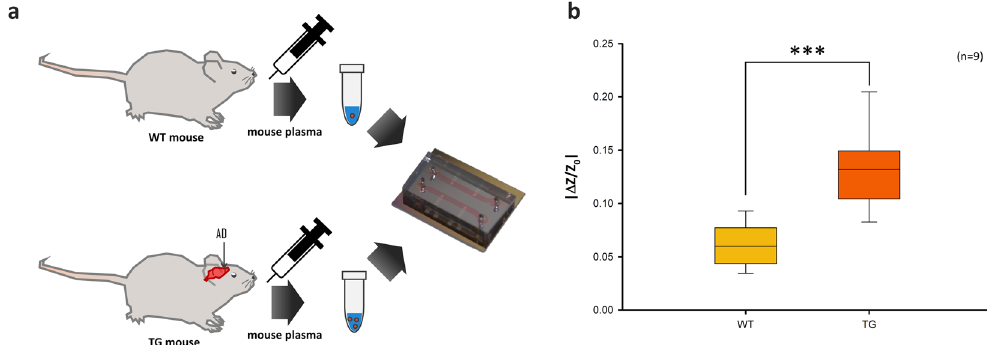
Figure 5. Mouse model test. ( a ) Scheme for mouse plasma collection and detection. ( b ) Mouse plasma sample test for discrimination between AD and healthy controls (n = 9, *** significant at p <